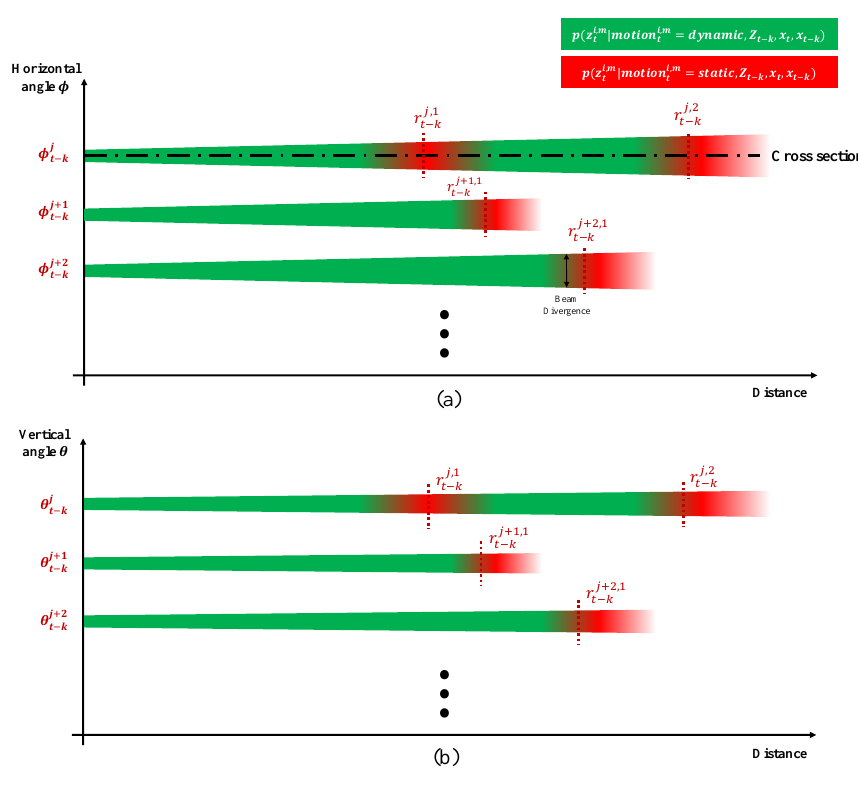
+ 1,1 + 2,1 , z j ,2 , z j and z j t − k t − k t − k t − k